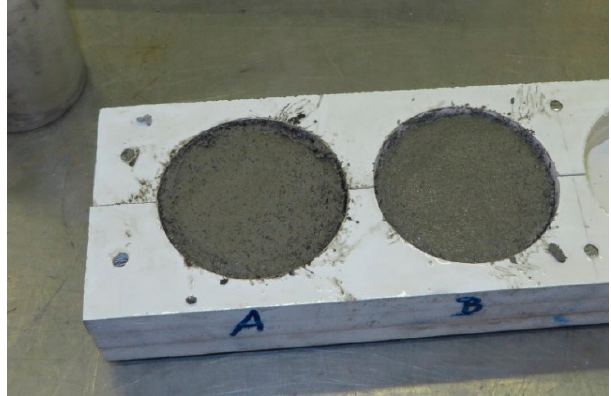
Figure 2. Small-scale cylindrical molds and specimens.